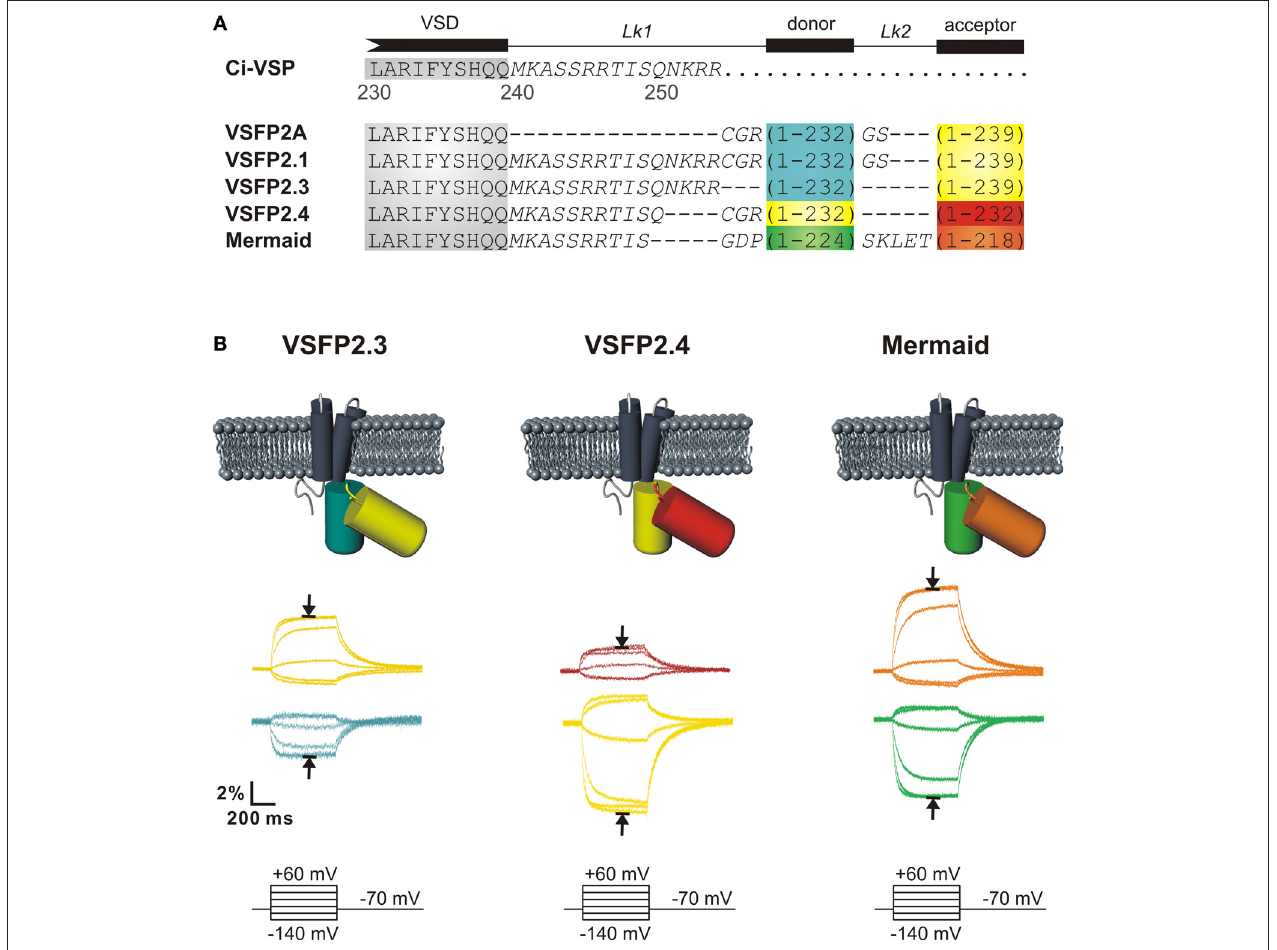
FIGURE 2 | Second generation voltage-sensitive fl uorescent proteins. (A) Alignment of the amino acid sequences of VSFP2.1 variants. The C-terminal residues and downstream segment (240–254) of the VSD of Ci-VSP are shown in gray and italic text, respectively. FPs are mCerulean (blue), Citrine/ mCitrine (yellow), mKate2 (red), mUKG (green) and mKO κ (orange).